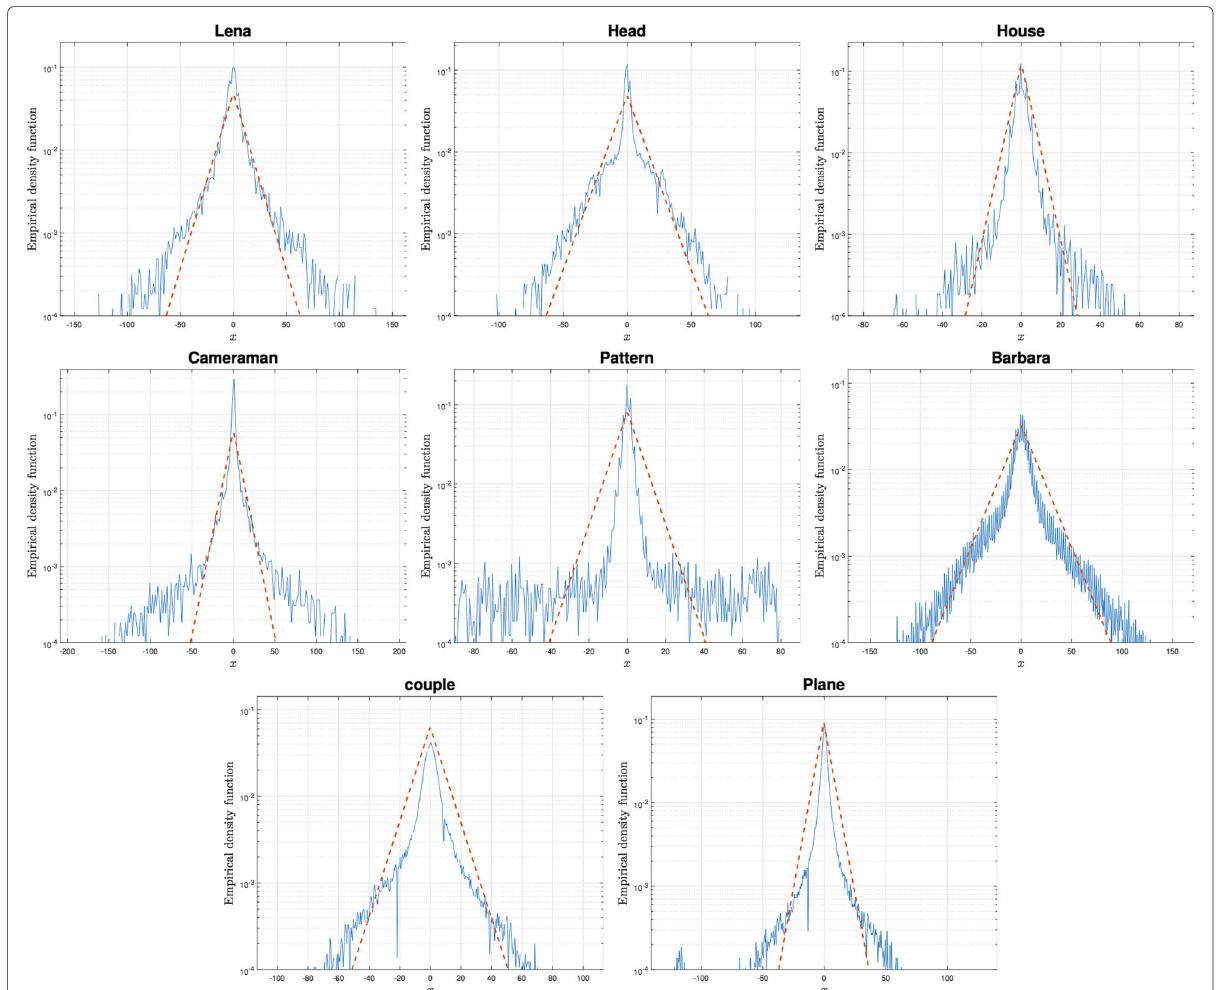
Fig. 2 Experiment 1: empirical density function in the log domain of a single vertical wavelet subband coefficients of several real images (solid) and the best fitting of the Laplace density function (dashed) obtained by maximizing the likelihood of the